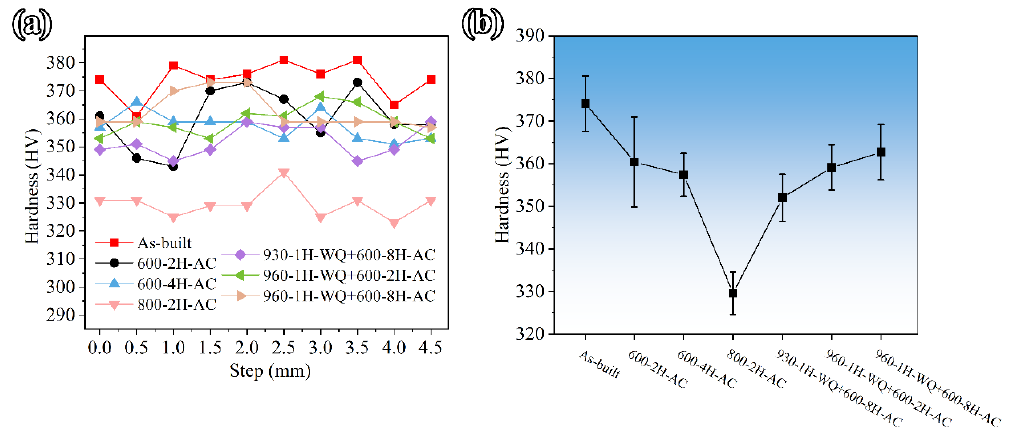
Figure 9. ( a ) The Vickers hardness of SLM TC4 (x-z); ( b ) The average Vickers hardness of SLM TC4 (x-z).